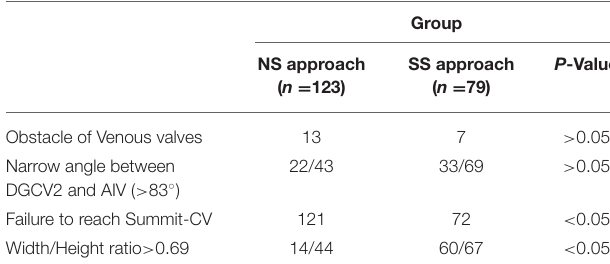
TABLE 2 | Reasons for failure of reaching target sites (Cases,%).